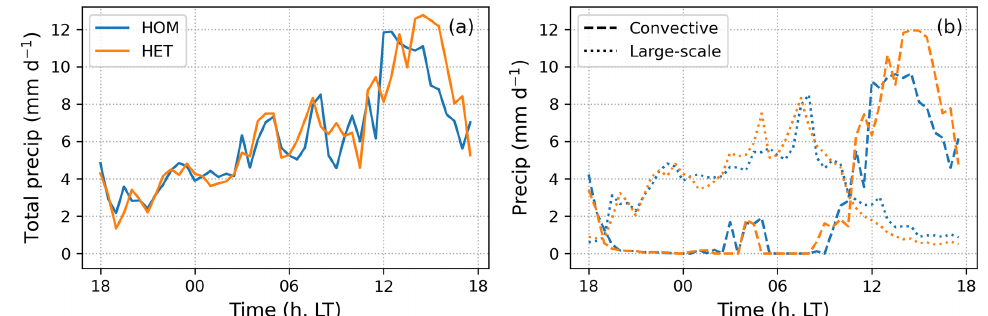
Figure 12. Diurnal cycle of (a) total precipitation and (b) convective versus large-scale precipitation from the HOM and HET SCM simula- tions averaged over 50 precipitating days out of the study period.